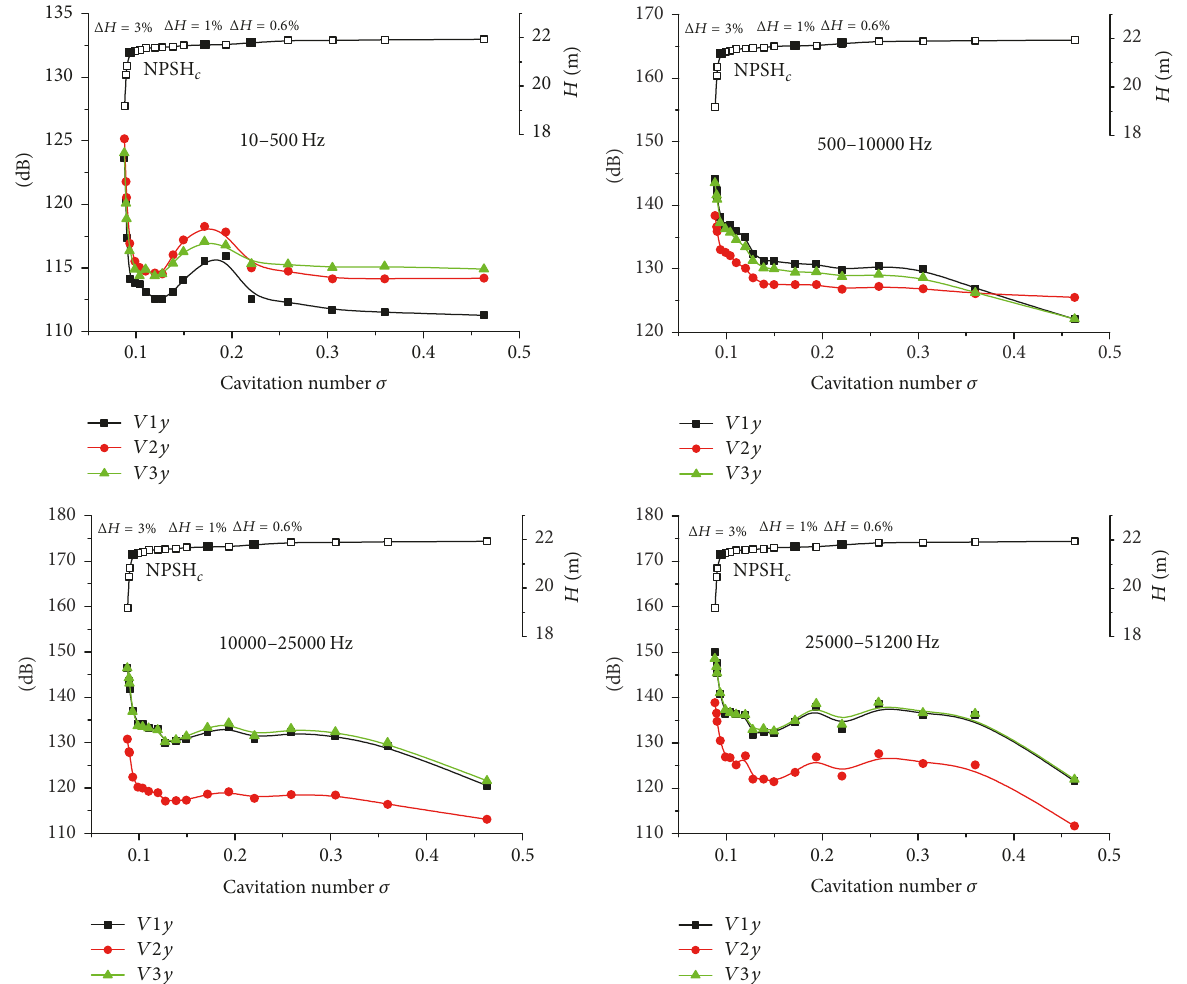
Figure 8: RMS values versus cavitation number in different frequency bands along 𝑦 -direction at nominal flow rate.